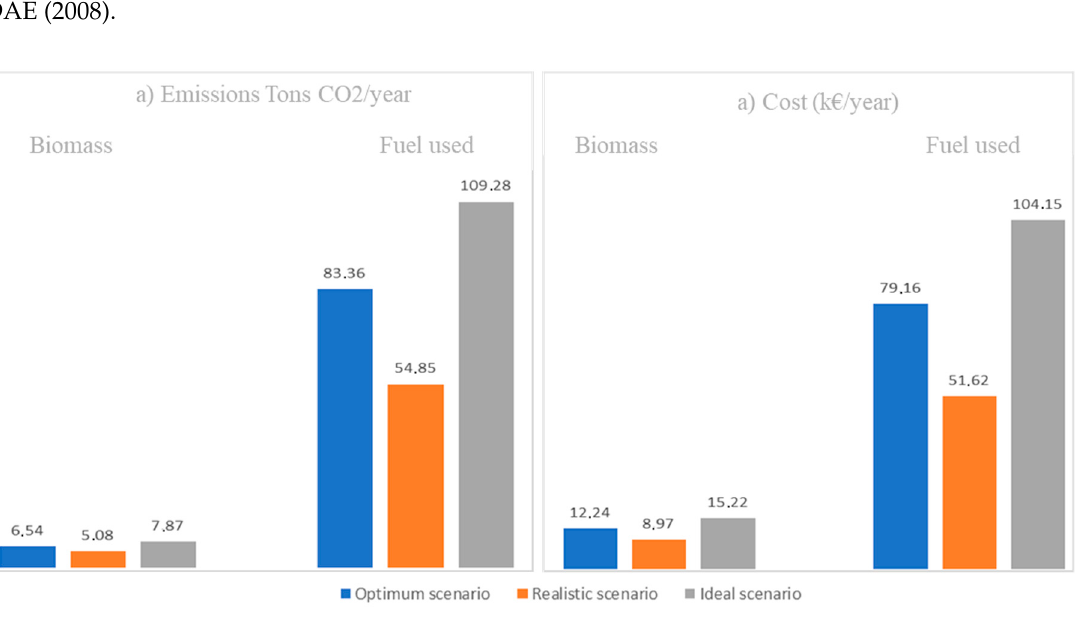
Table 3. Groups of municipalities.